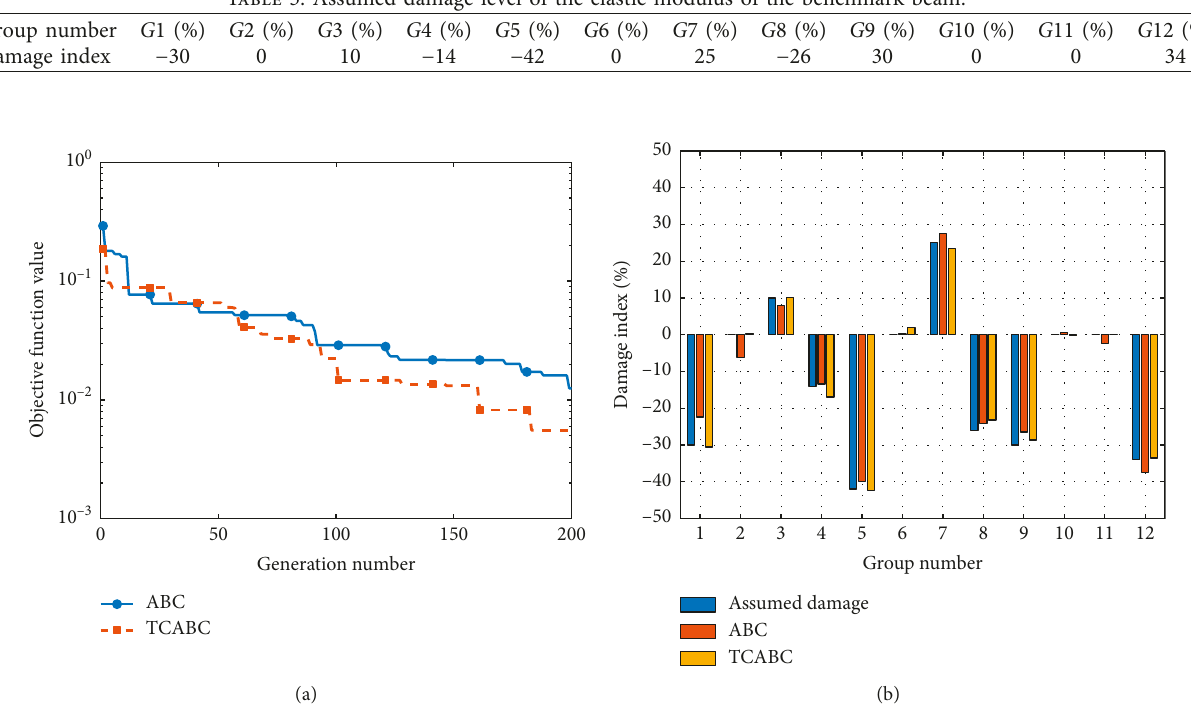
Figure 8: (a) The convergence performances of the objective function. (b) The identified parameters of the damage detection.